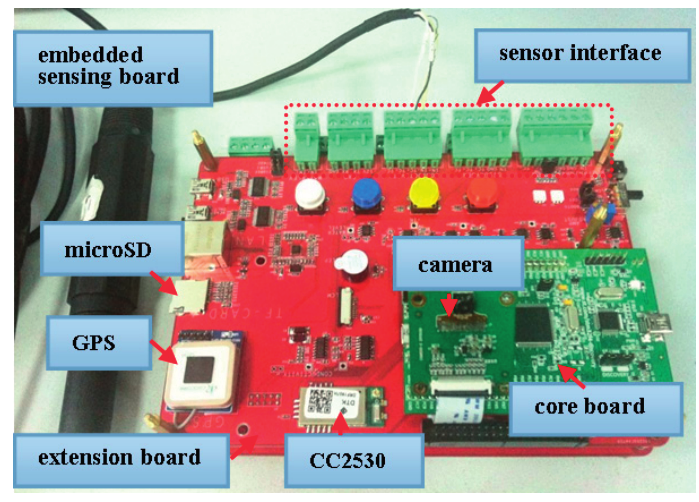
Figure 4. Embedded sensing